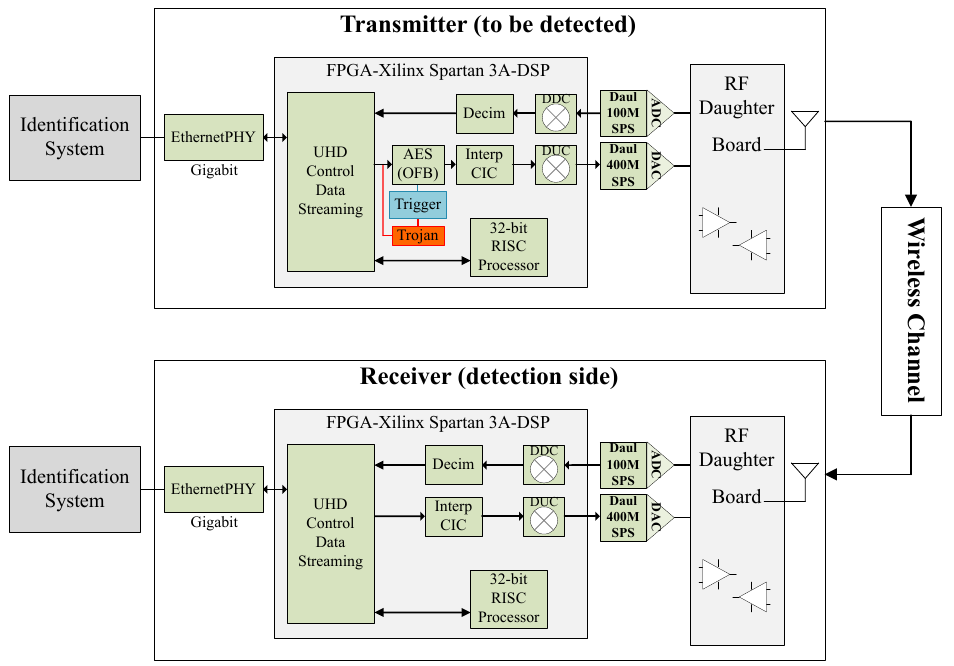
Figure 6. Trojan detection procedure along wireless communication flow block